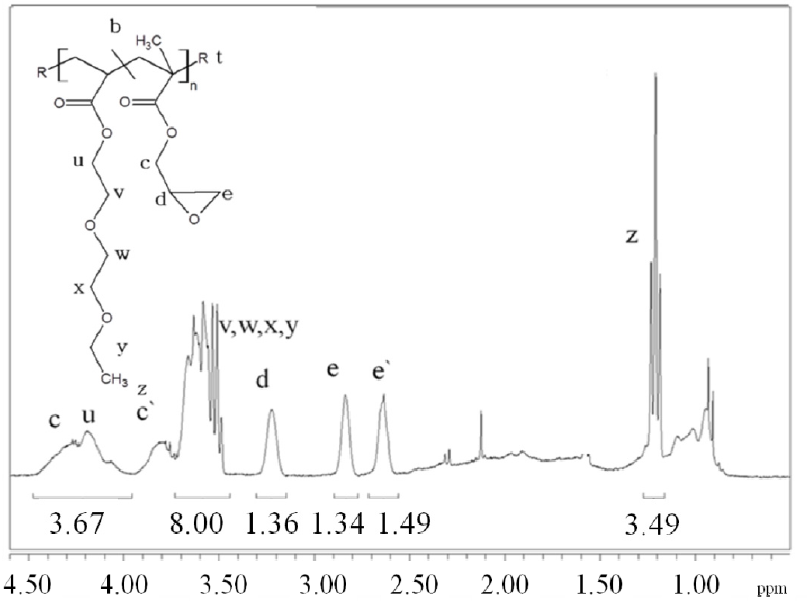
Figure 6. 1 H NMR spectra of P(E2EA- co